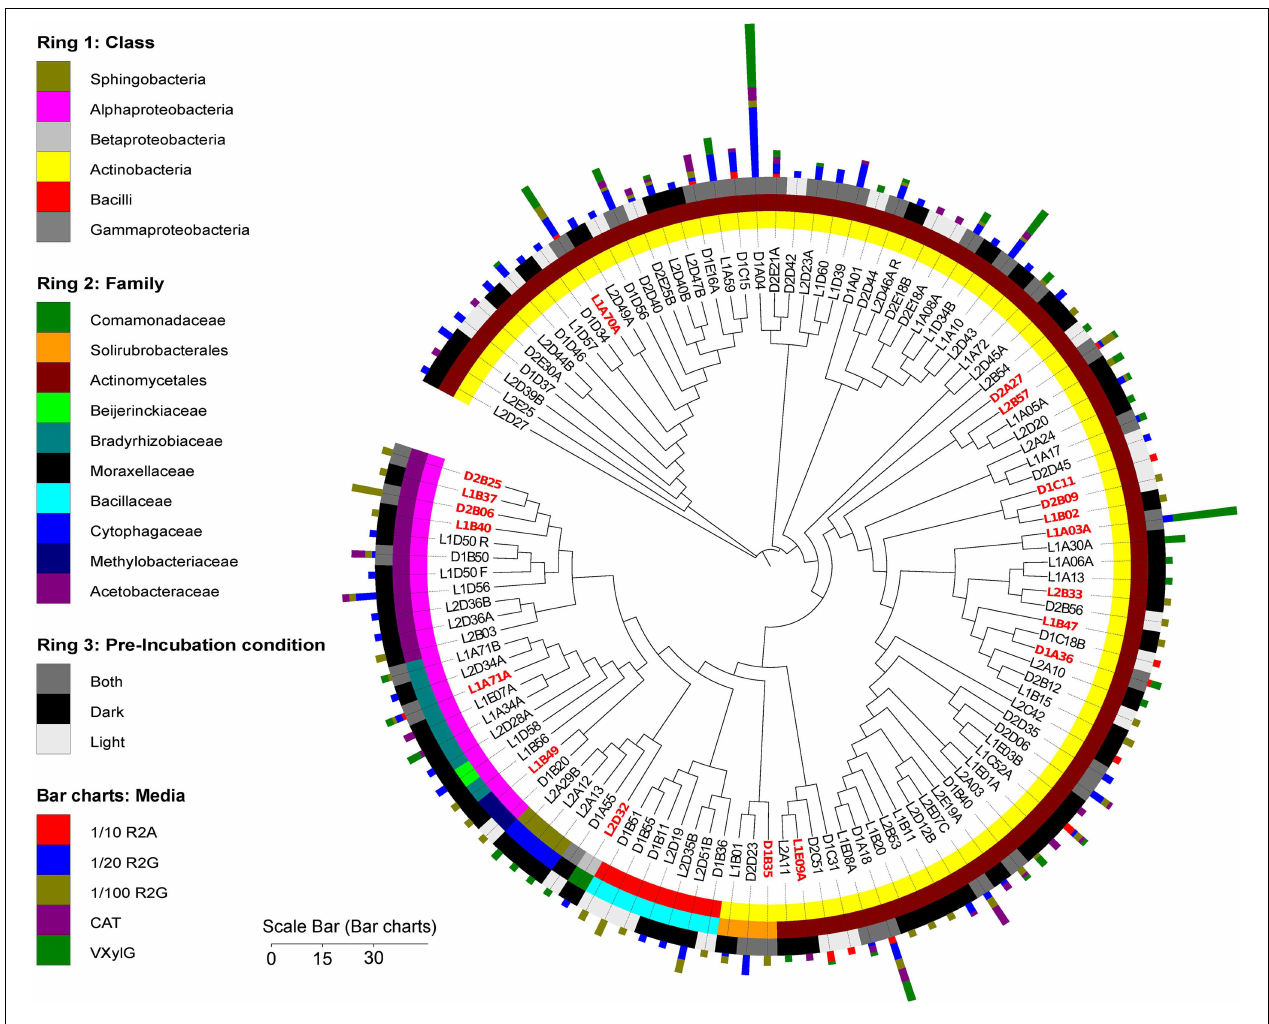
isolation procedures. Bar charts, the different media from where the isolates were recovered. Size of the bars indicates the number of isolates in each of the clusters. Red and bold leaf labels indicate which representative sequences clustered at 97% similarity with OTUs reconstructed from the metagenome or metatranscriptome libraries. Scale bar indicates the number of isolates per representative